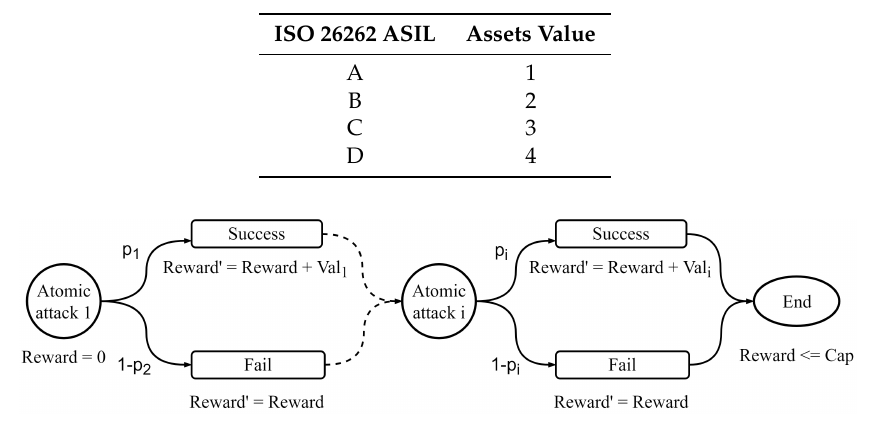
Table 2. Assets value based on ISO 26262 ASIL.